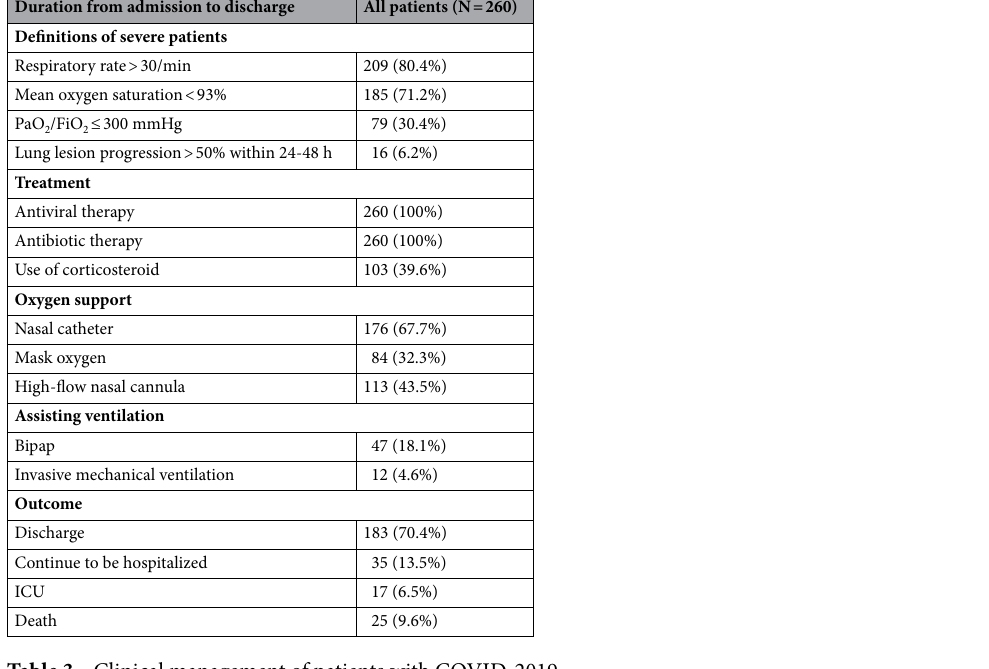
Table 3. Clinical management of patients with